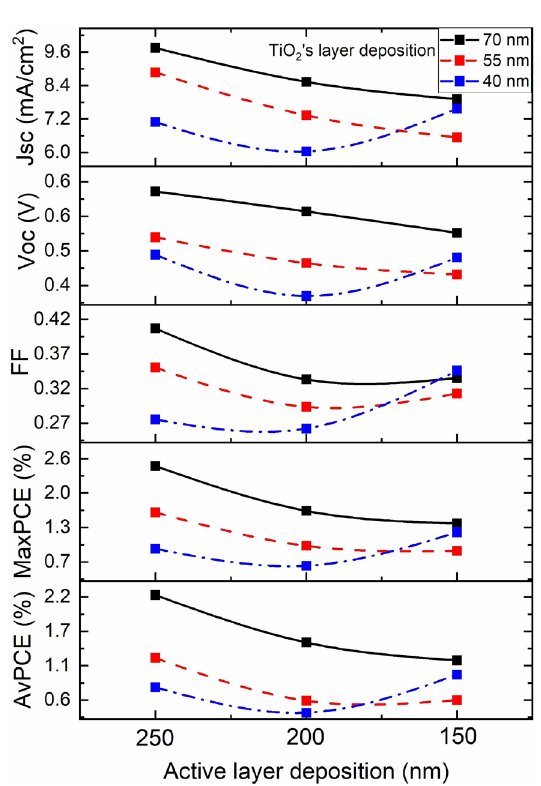
Figure 8. Parameters and tendence line of the thicknesses variation in cells according to the Experiment